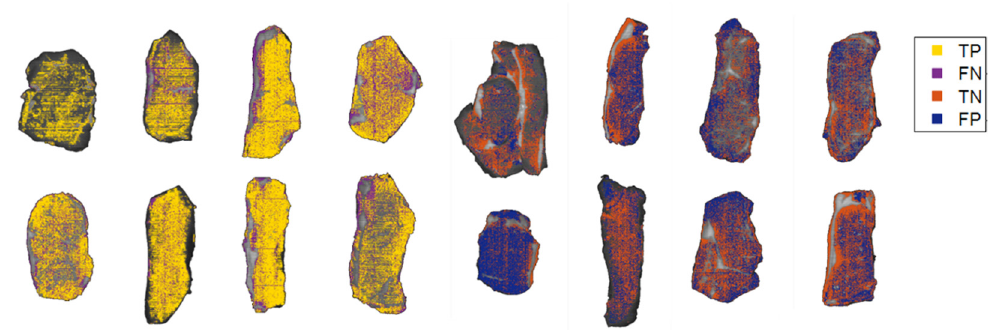
Figure 7. Tenderness distribution maps of the external validation samples after classification (1st der + MC). The steaks on the first four columns represent the samples used to test group 1 whereas the remainders gather the ones employed to validate the group 2. TP = true positive; FN = false negative; TN = true negative; FP = false positive.